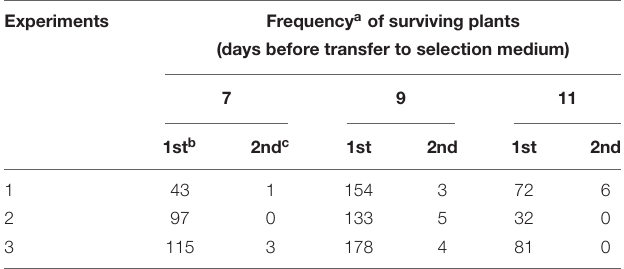
TABLE 1 | Frequencies of surviving plants in the course of the selection. Experiments Frequency a of surviving